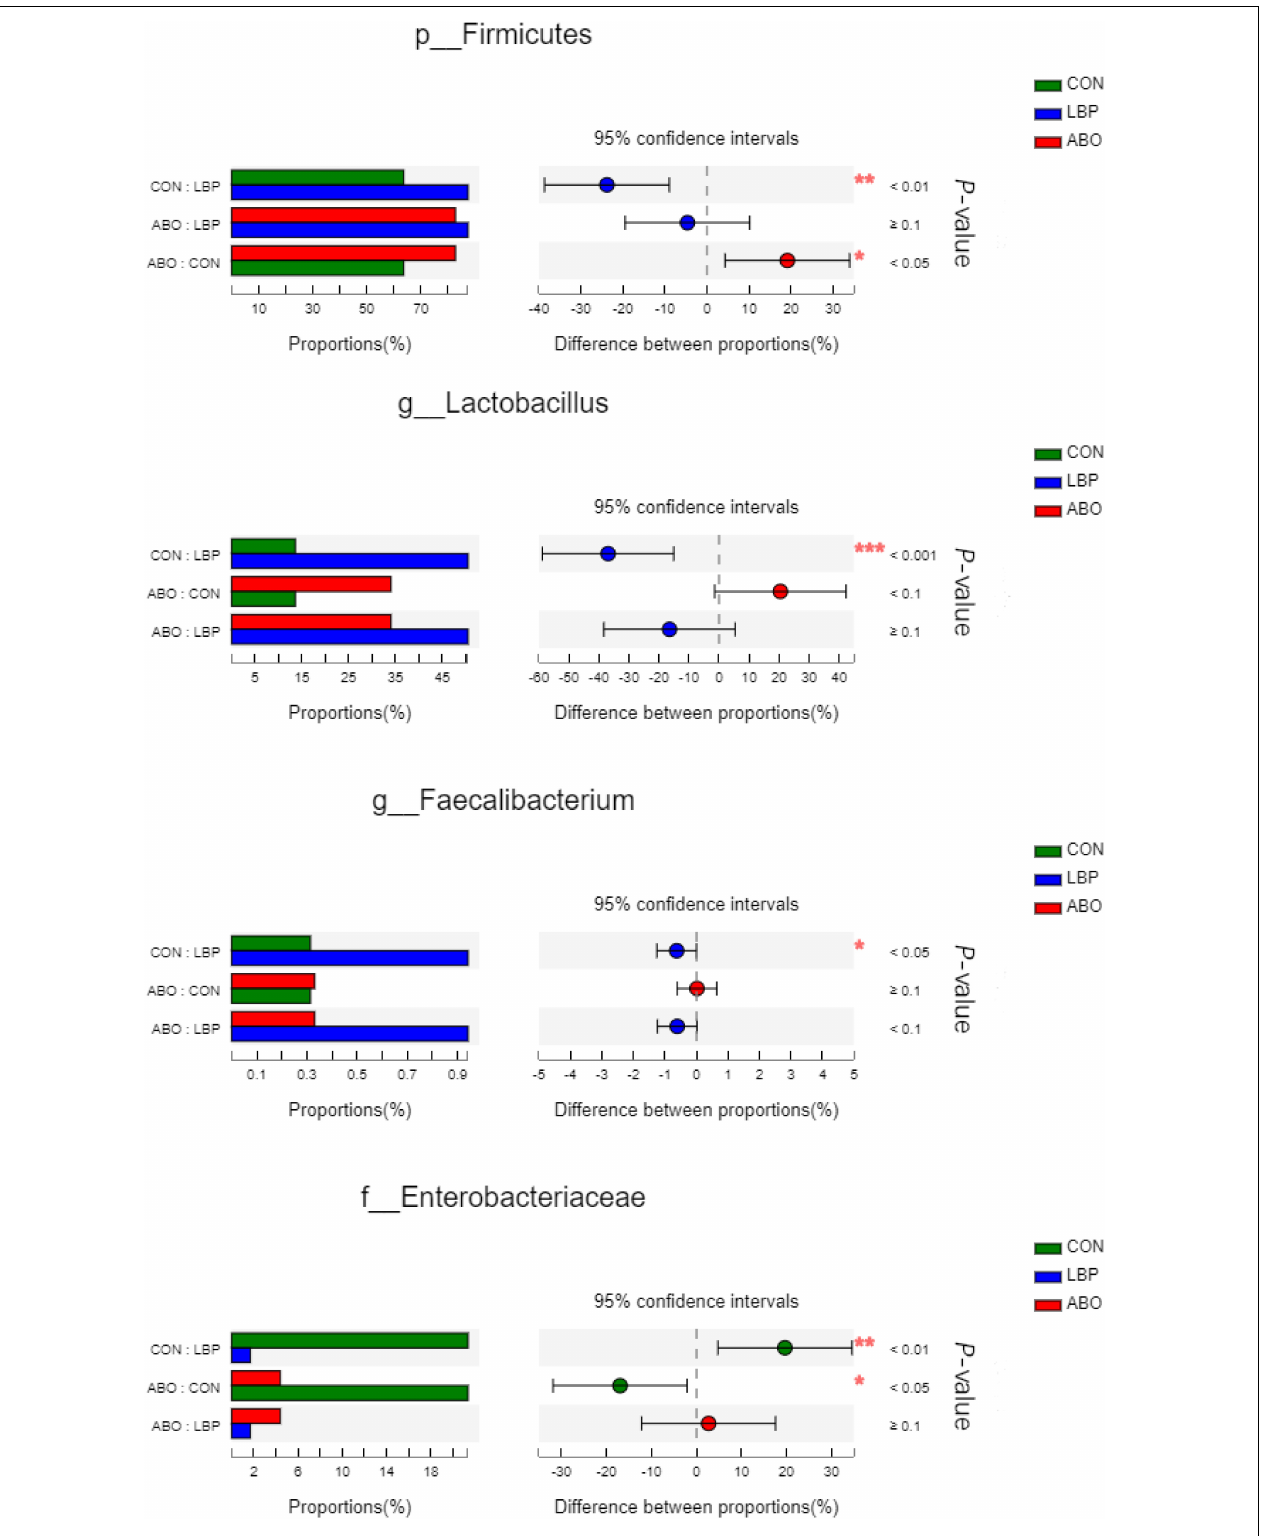
FIGURE 3 | Comparative analysis of 3 most relative abundances of gut microbiota ( n = 8). Kruskal–Wallis test followed by Tukey test was used to evaluate the statistical significance. Asterisks express statistical differences between different groups: *0.01 < P ≤ 0.05, **0.001 < P ≤ 0.01, *** P ≤ 0.001. CON, basal diet; LBP, basal diet + 4,000 mg/kg LBPs; ABO, basal diet + 20 mg/kg flavomycin + 50 mg/kg quinocetone.